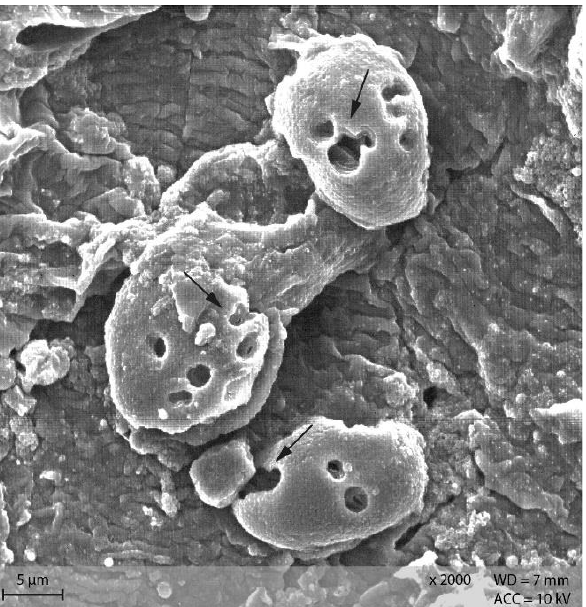
Figure 12. Starch granules from the posterior small intestine, showing large and partly confluencing holes (indicated by ↓ ). Example from diet PEL, scanning electron microscopy.